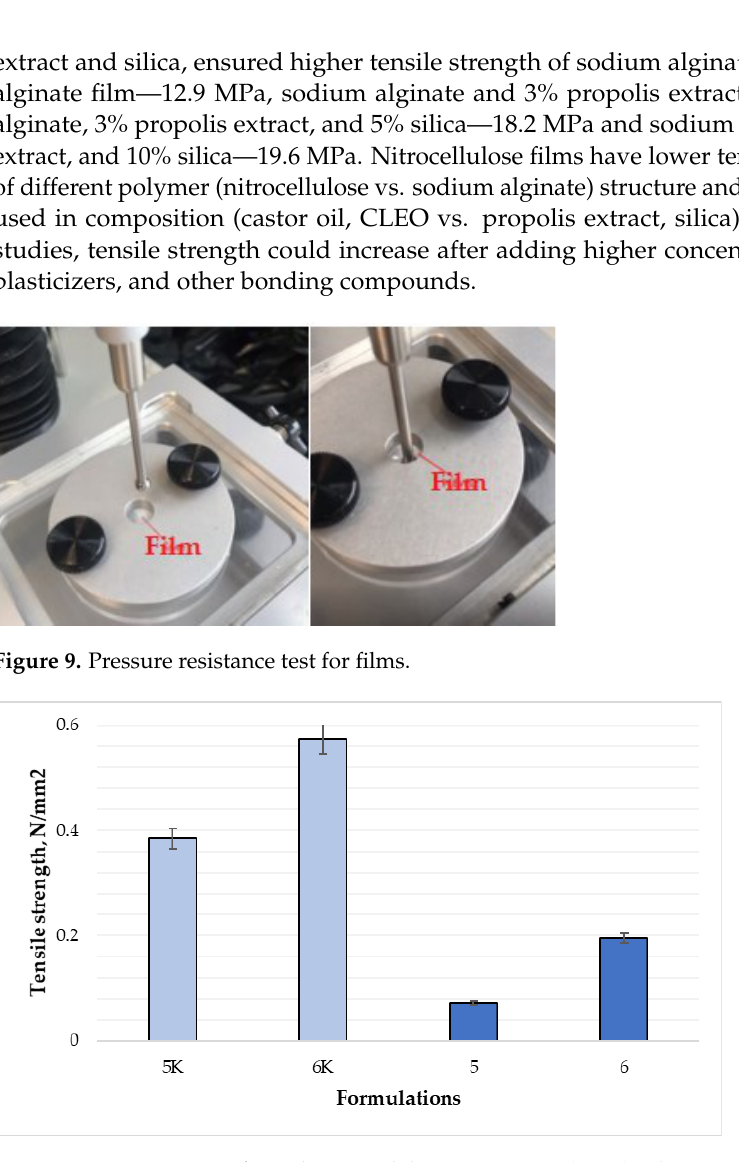
Figure 10. Comparison of tensile strength by composition (n = 6). The composition values are given in Table 1. p < 0.05 between 5 and 5K; 6 and 6K; 5 and 6 compositions.